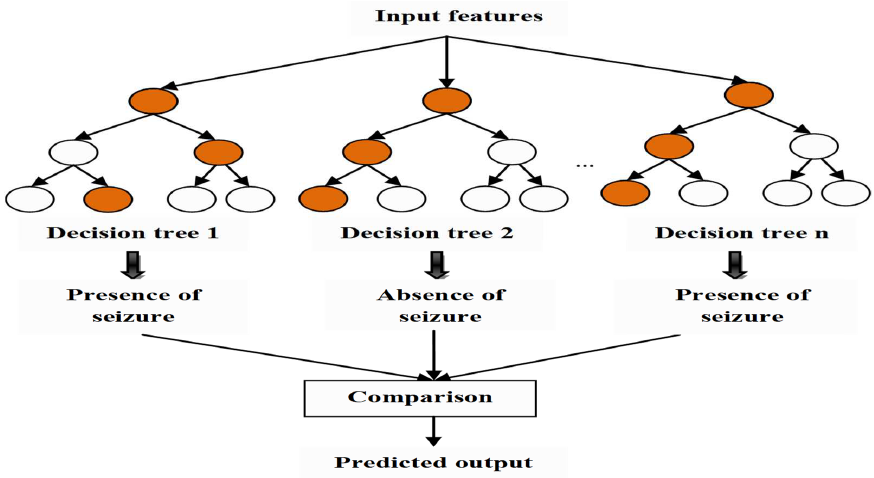
Figure 7. The architecture of the decision tree classifier.